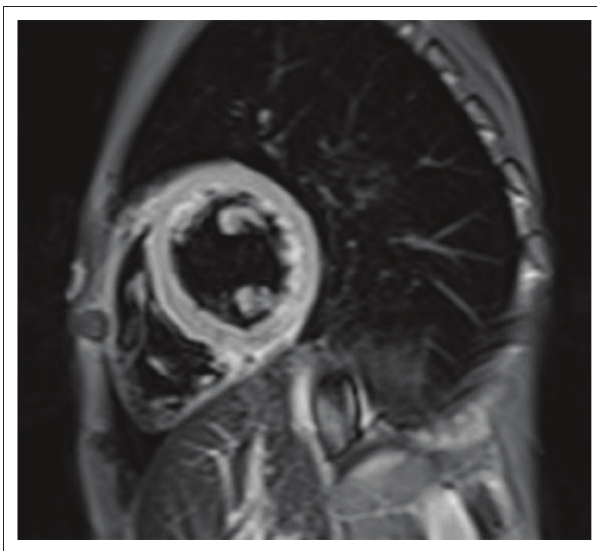
FIGURE 2: T2-weighted STIR image at the level of the mid-left ventricle shows an elevated myocardial skeletal muscle signal intensity ratio (SIR) of 2.5 (normal < 1.9) in keeping with diffuse myocardial